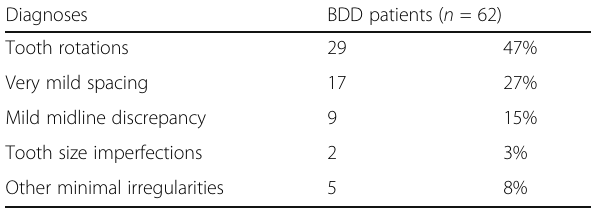
Table 3 Orthodontic concerns in BDD patients